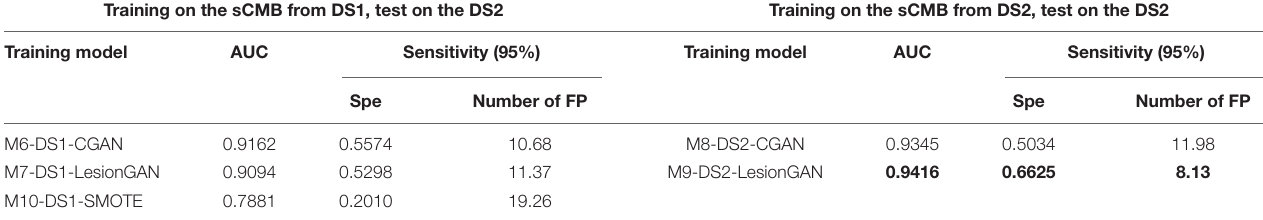
TABLE 5 | Results of cerebral microbleed (CMB) patch classification. Training on the sCMB from DS1, test on the DS2 Training on the sCMB from DS2, test on the